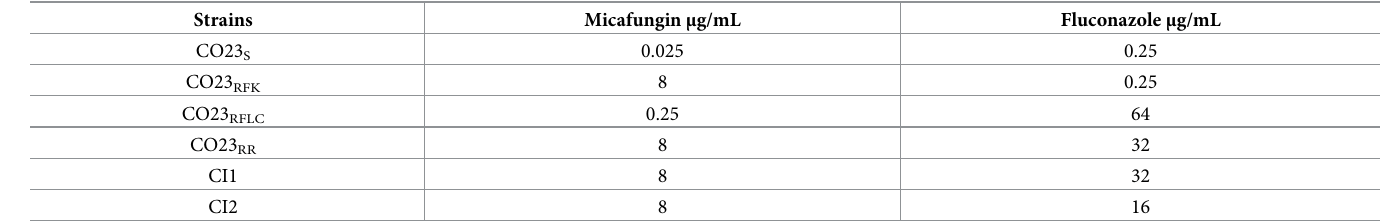
Table 3. Antimicrobial activity (MIC) of Fluconazole and Micafungin on different C . albicans strains. Strains